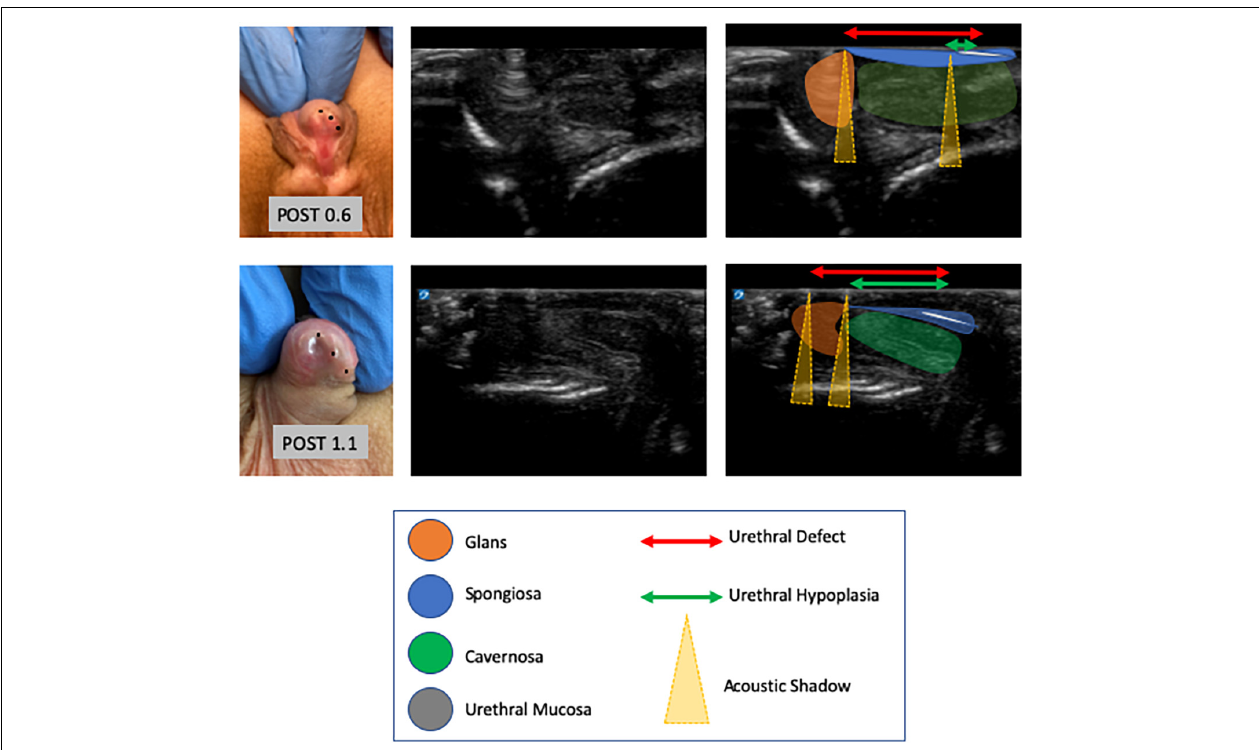
FIGURE 2 | Images of hypospadias cases with their corresponding POST values (left column) and subsequent PUG images (middle column) with annotations shown in the third column (right). To better define the extent of urethral under-development, we defined urethral hypoplasia as the distance from the spongiosal bifurcation to the hypospadias meatus, whereas urethral defect was defined as the distance from the spongiosal bifurcation to the B-B line. We observed that a longer urethral defect was detected in more severe cases of hypospadias, when stratified according to meatal position, and that longer urethral defect correlated with lower POST values ( p =